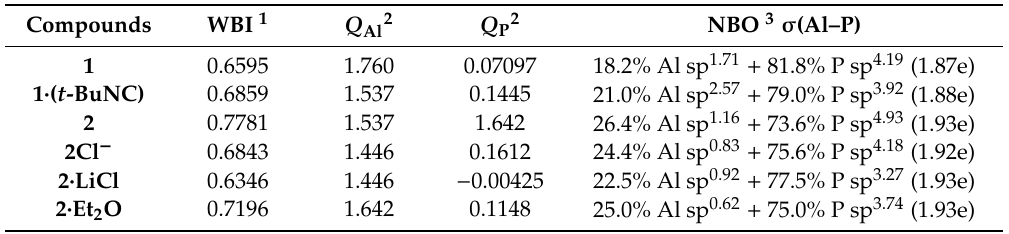
Table 2. Summary of NBO